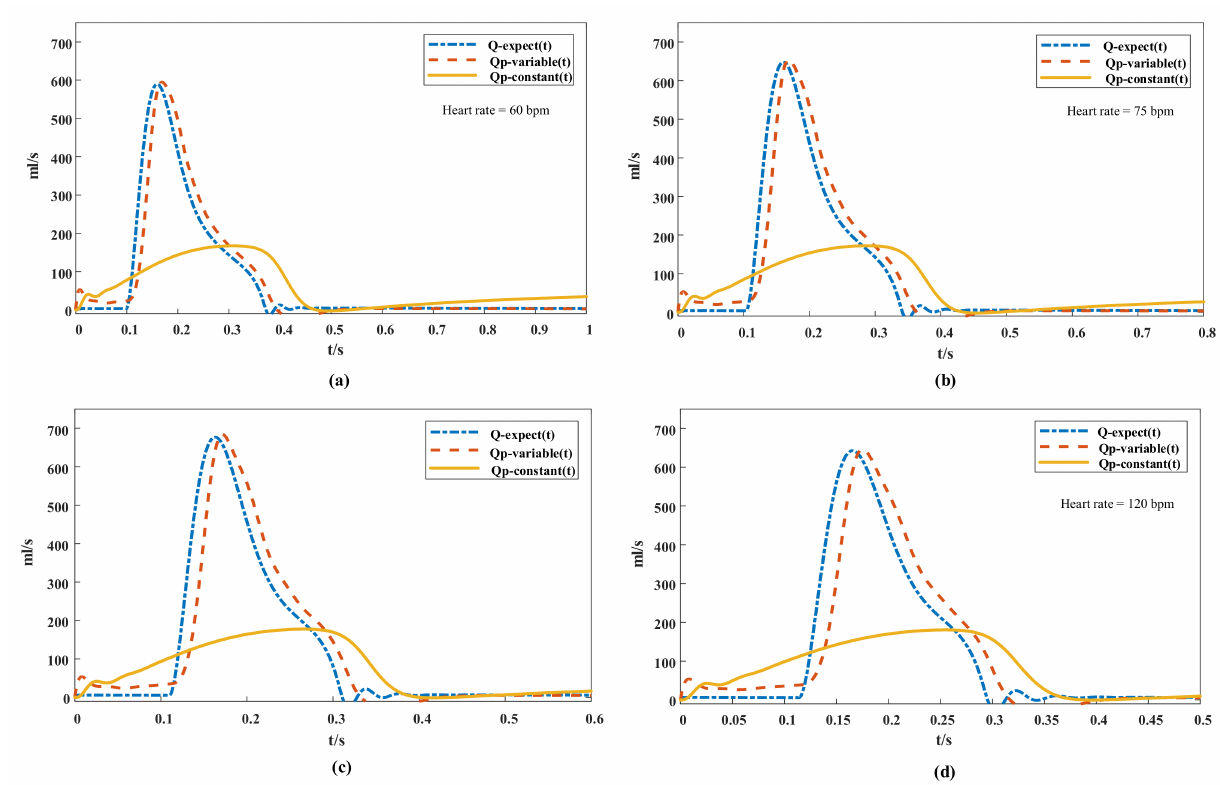
Figure 7. Comparison of flow curve at different heart rates: Q-expect (t) is the expected quantity of flow, QP -variable (T) is the variable-speed pump flow, QP-constant (T) is the constant-speed pump flow. ( a ) heart rate = 60 bpm, ( b ) heart rate = 75 bpm, ( c ) heart rate = 100 bpm, ( d ) heart rate = 120